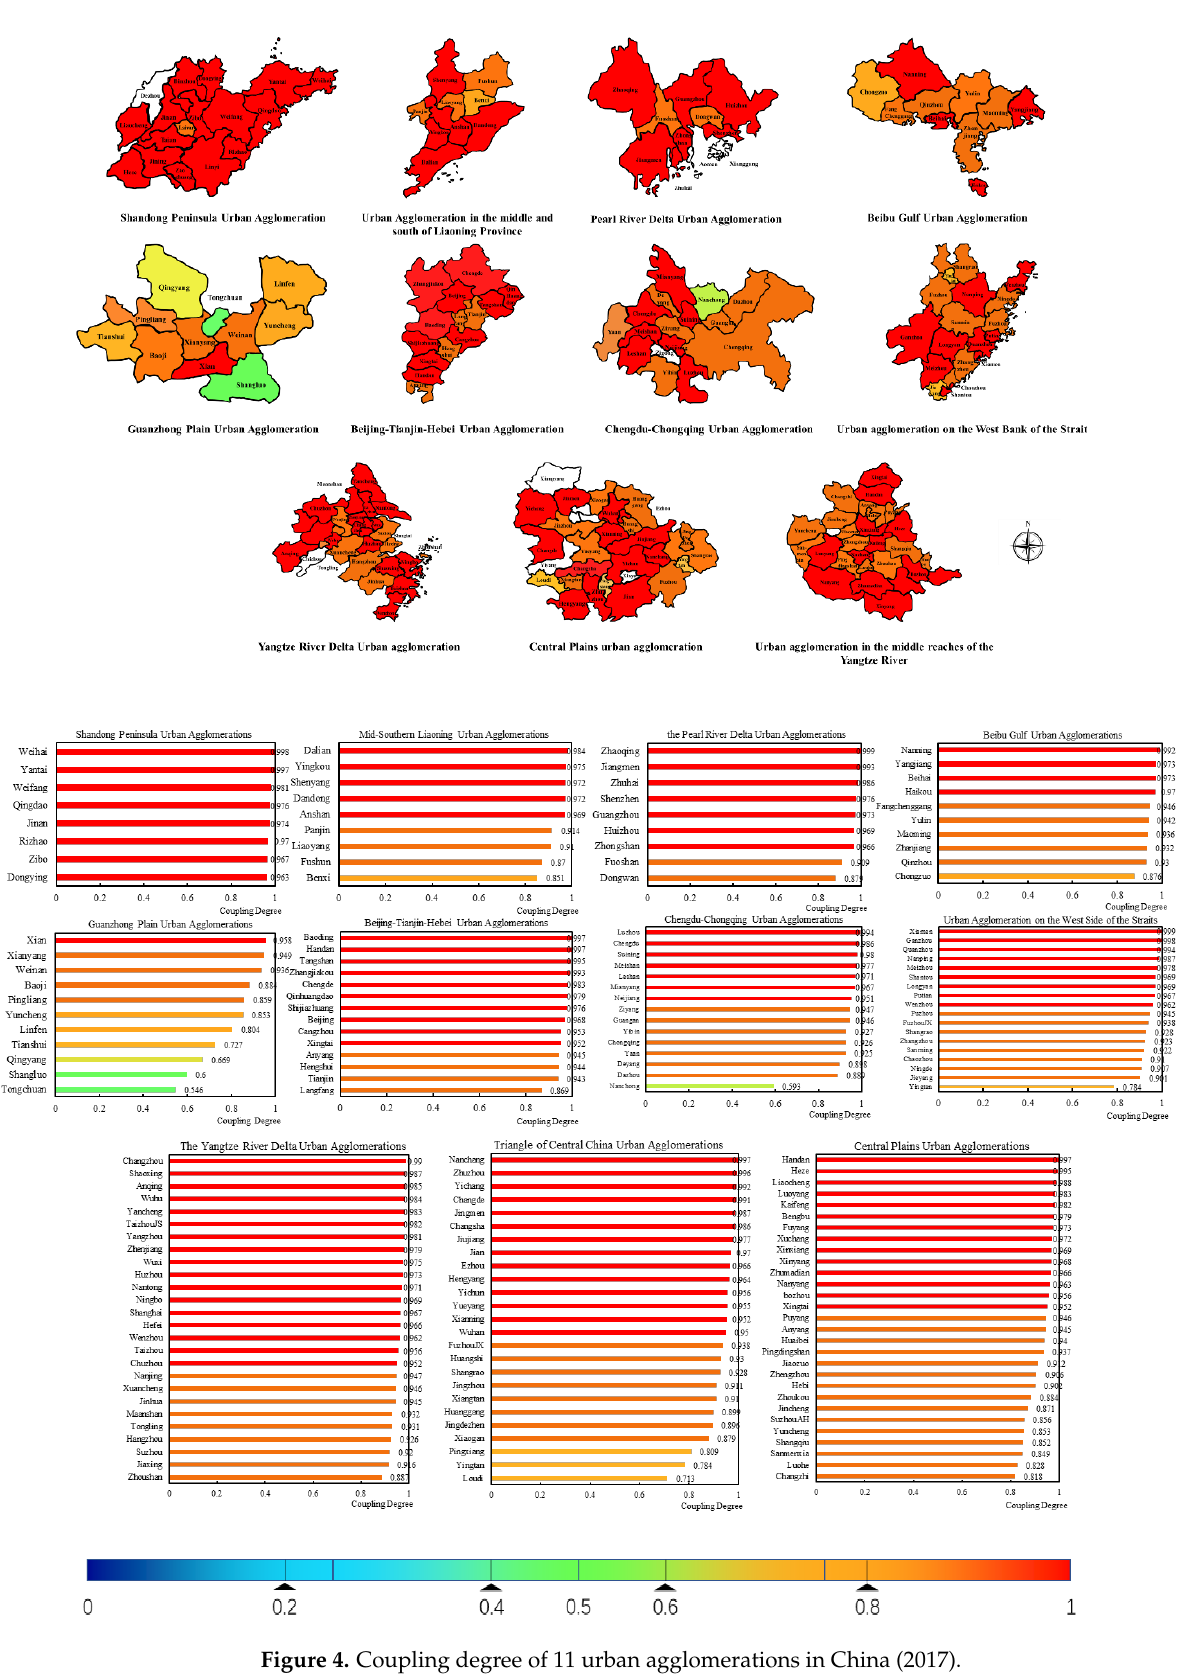
Figure 4. Coupling degree of 11 urban agglomerations in China (2017). Secondly, the degree of coordination model should be used to measure the adequacy level of coordination between population growth, land use and housing supply. The